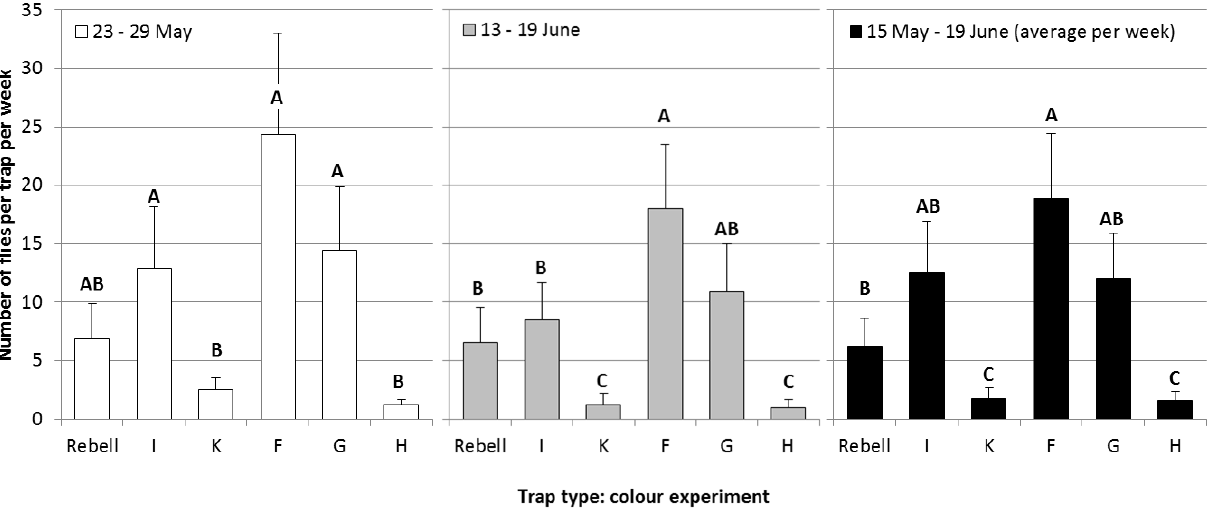
Figure 4. A comparison of differently-colored yellow sticky panels on the numbers of captured cherry fruit flies per week (+SE) during the second week of experiments (white bars), the fifth week of experiments (grey bars) and during the whole experimental period (black bars; average per week; Tukey’s HSD test p = 0.05; different letters show significant